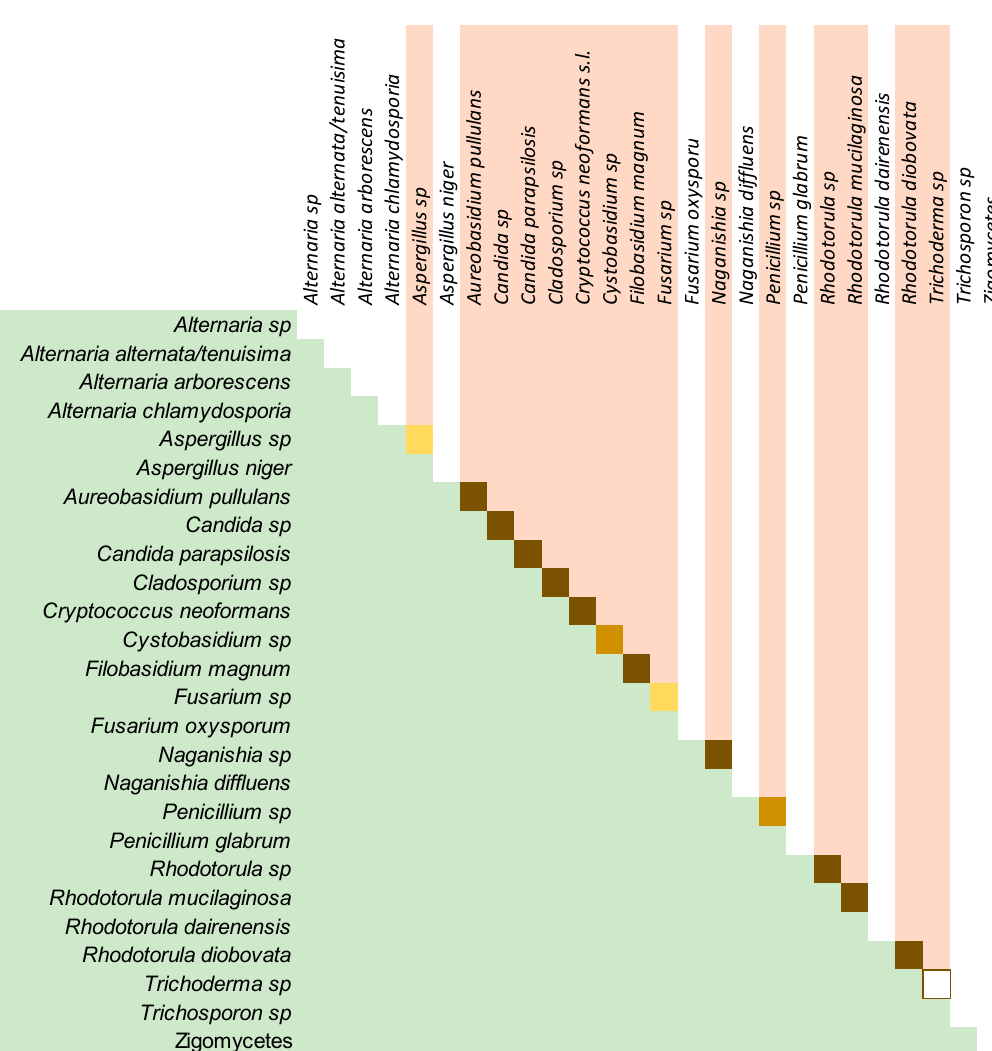
Figure 9. Concordance between the detection of fungi by culture and by the HTS method. Green background: Genera and species obtained by the culture. Pink background: same genera and species in the HTS analysis. The co-occurrence of detection in the same samples is represented by squares at the intersection. Dark squares: 100% of positive samples by culture were detected by HTS. Golden squares: 40% and 70% of coincidence in culture and HTS (from left to right and up to down). Yellow squares: from 17% to 25% of coincidence. Empty squares: Detection in different samples (0% coincidence).